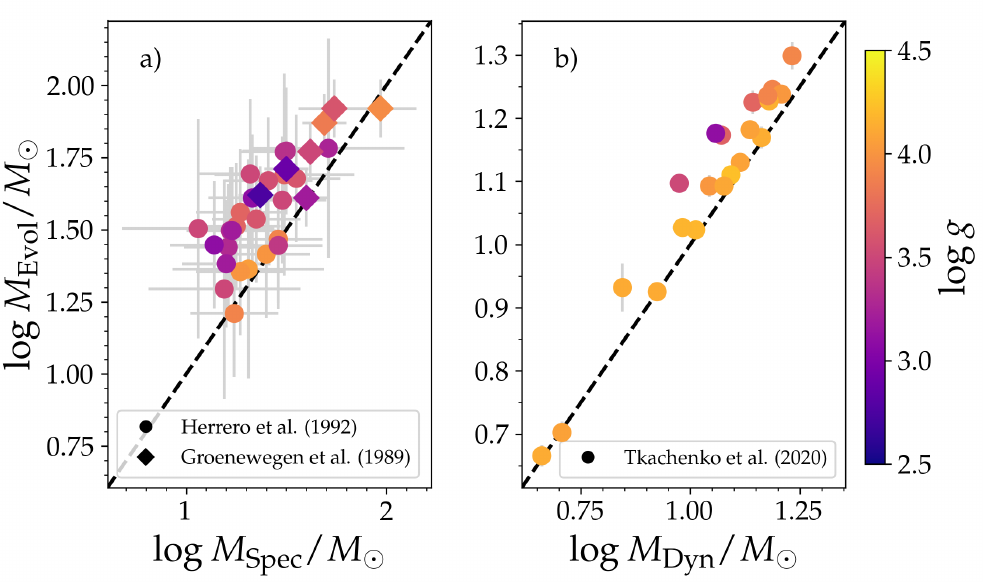
Figure 10. Examples of observed mass discrepancies. Better agreement between both M Evol - M Spec and M Evol - M Dyn is generally found for less evolved stars. ( a ) Observed mass discrepancy between spectroscopic (x-axis) and evolutionary (y-axis) masses derived for a sample of 32 high-mass stars [245,246]. Similar errors to those for M Spec were assumed for M Evol for the round data points. ( b ) Observed mass discrepancy between dynamical (x-axis) and evolutionary (y-axis) masses derived for a sample of 11 double-lined eclipsing binaries [77]. Errors on the measurements are typically smaller than the size of the data points. Figure made by the authors using data from Groenewegen et al. [245], Herrero et al. [246], and Tkachenko et al.